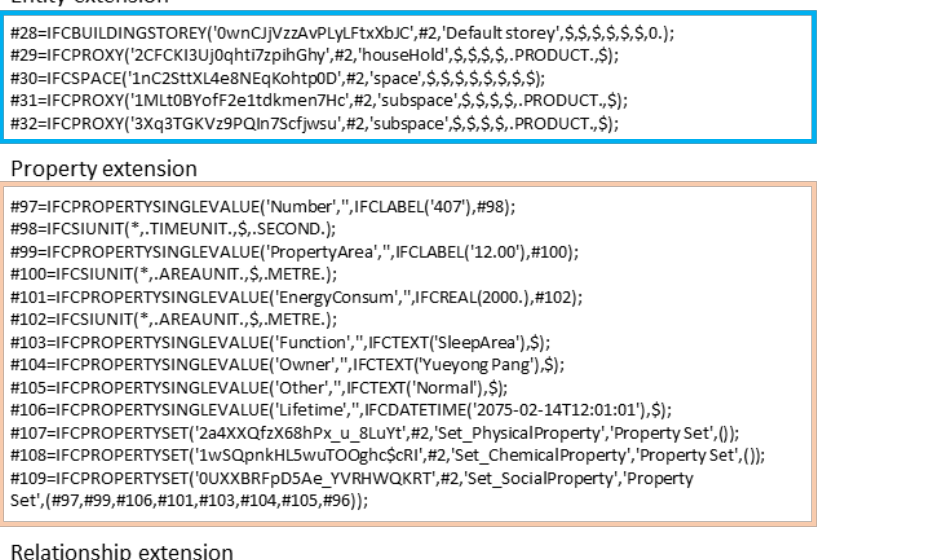
Figure 14. Data fragments of the ifc file about the extension model.